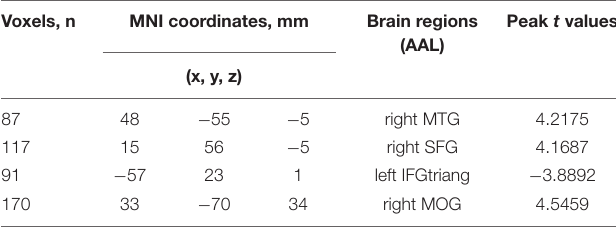
TABLE 2 | Brain regions with significant differences in CBF between IGE and HC